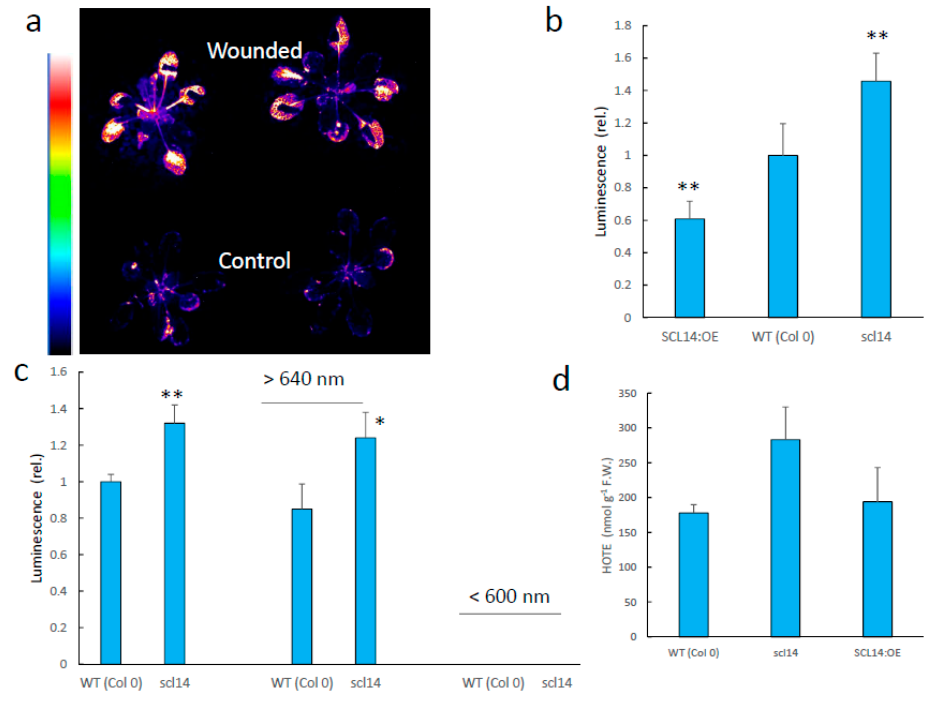
Figure 10. Leaf wounding and cellular detoxification capacities. ( a ) Effects of leaf wounding on the luciferin/luciferase luminescence of Arabidopsis pAER:LUC plants. ( b ) Intensity of wounding- induced leaf SCL in WT Arabidopsis and in the scl14 mutant and the SCL14:OE . ( c ) wounding-induced SCL in two spectral domains (<600 nm and >640 nm). ( d ) HOTE levels. * and **, significantly different from WT at p < 0.01 and 0.005, respectively (Student’s t -test).